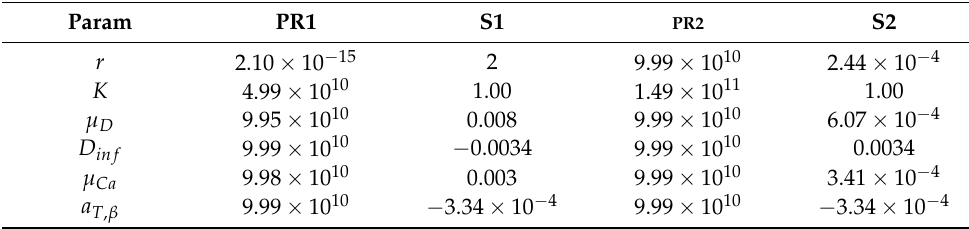
Table 3. Parameter Sensitivity